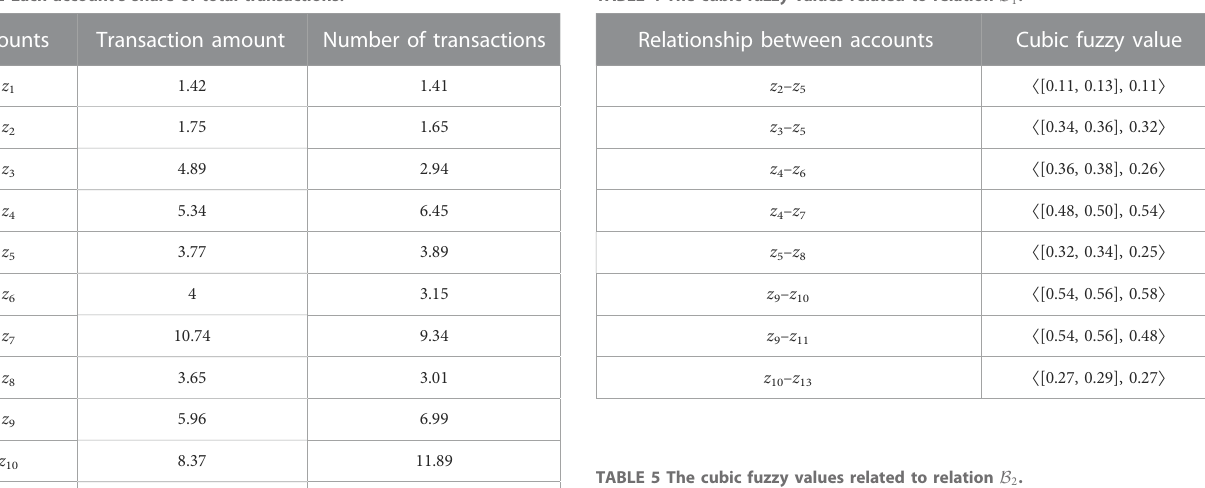
TABLE 5 The cubic fuzzy values related to relation B